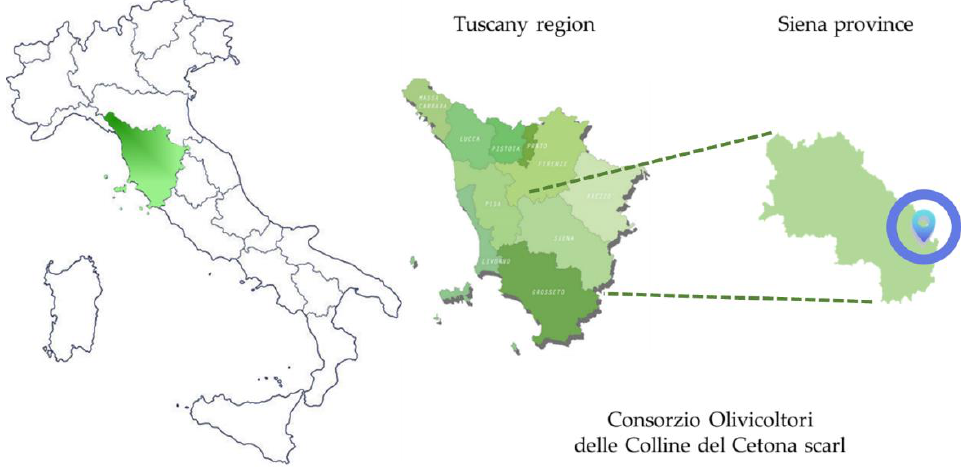
Figure 1. Geographical distribution of the samples of EVOO.